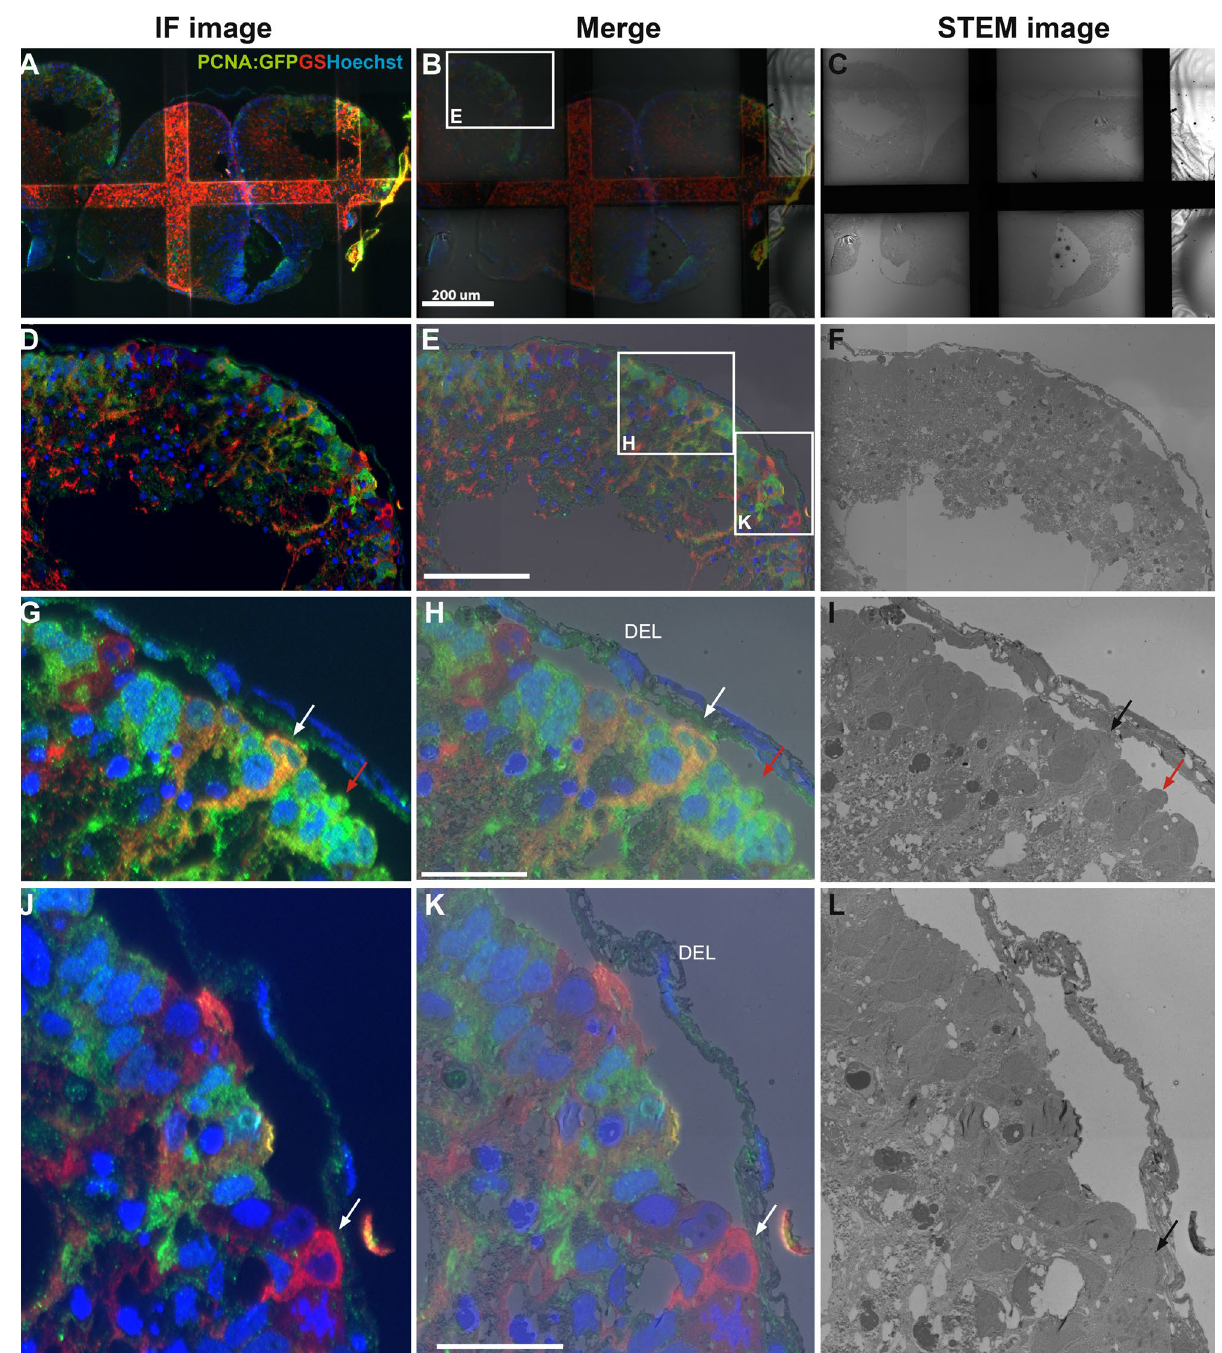
Figure 5. i CLEM imaging using STEM. Merged images (middle column) illustrate exact overlay of immunofluorescent (IF) images (left column) and STEM images (right column) using MAPS software. ( A–C ) Reconstructed tile-sets of STEM images of the adult zebrafish forebrain in cross-section on grids bars using MAPS software at low resolution. White box in ( B ) depicts region displayed in ( D-F ). ( D-F ) Dorsal view of zebrafish pallium showing dense row of labelled cells below thin dorsal ependymal lining (DEL—see panel H). White boxes in ( E ) depict regions displayed at higher magnification in ( G–I ) and ( J–L ). ( G–I ) GS + /PCNA:GFP + radial-glial cell ( orange ; white/black arrow) contrasted with a neighbouring GS - /PCNA:GFP + cycling cell ( green ; red arrow). ( J–L ) Example of a GS + /PCNA:GFP − cell profile ( red ; white arrow). Scale bar ( B ) 200 µm; ( E ) 80 µm; ( H , K ) 20